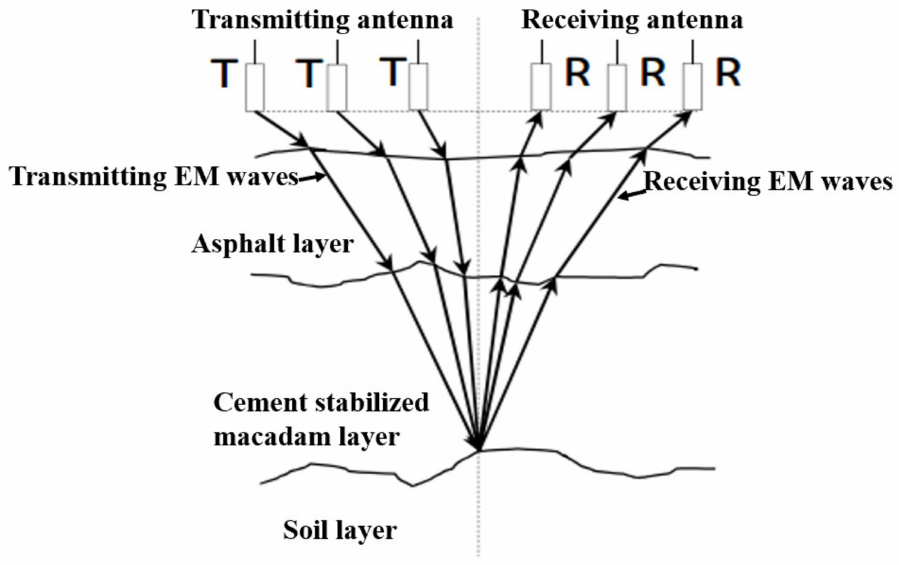
Figure 3. Schematic diagram of